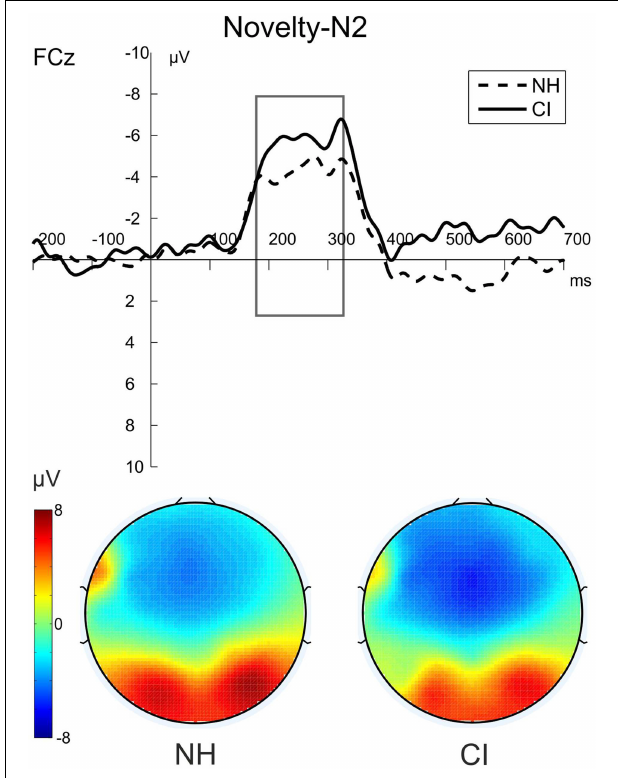
FIGURE 4 | The novelty-N2 (novel-standard difference waveforms) for NH participants (dashed) and CI users (solid) in the visual-auditory DFD. The figure shows the ERPs at FCz and the voltage maps illustrating the mean over the analyzed time window (180–330ms) for NH participants on the left and for CI users on the